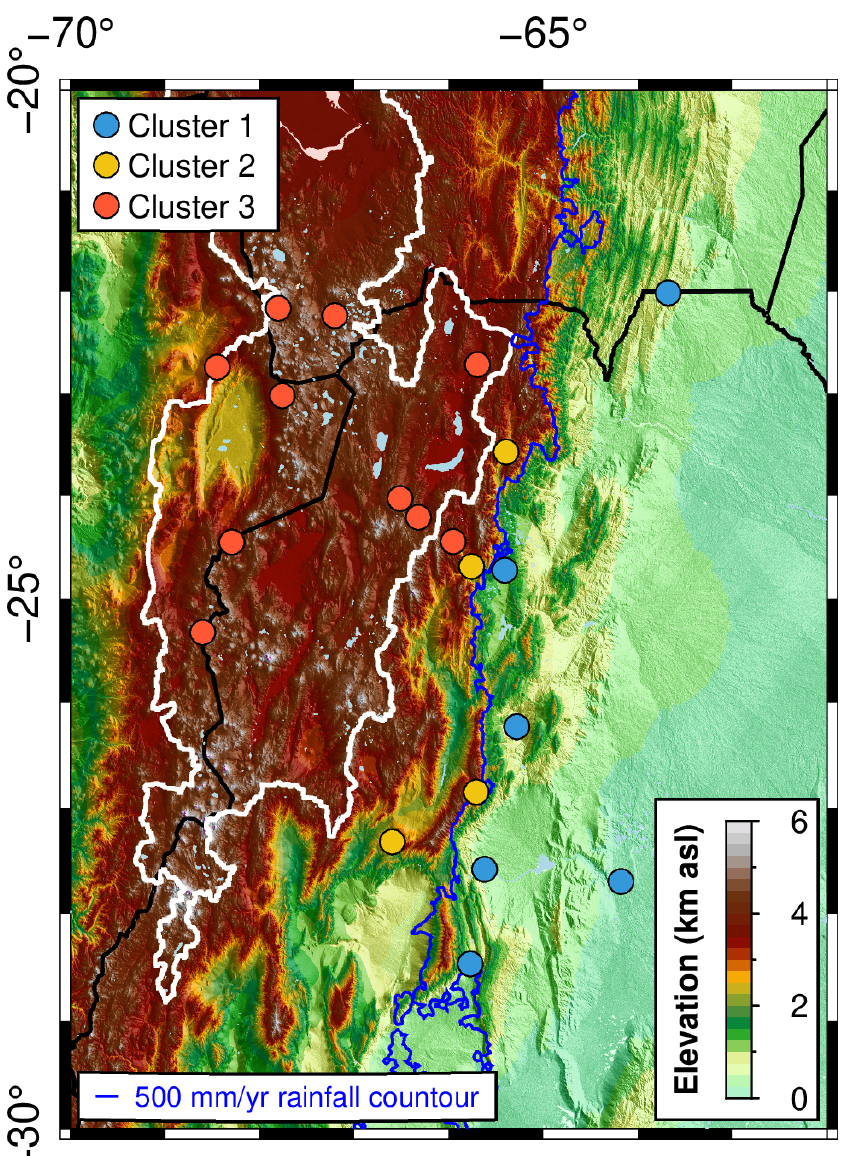
Figure 5. Map view of the clustered stations using the monthly mean values during 2014. Circle colours are similar to Figure 4. The stations with elevations up to 1225 m asl are located in the foothill zone (blue points), the sites with elevation between 2000 m and 2700 m asl are located in the transition zone (yellow points), and almost all stations above 3115 m asl are situated on the Altiplano–Puna plateau (red points). (Topographic data obtained from ETOPO1 [18], rainfall information retrieved from Tropical Rainfall Measuring Mission (TRMM) [20], as cited in Bookhagen and Strecker